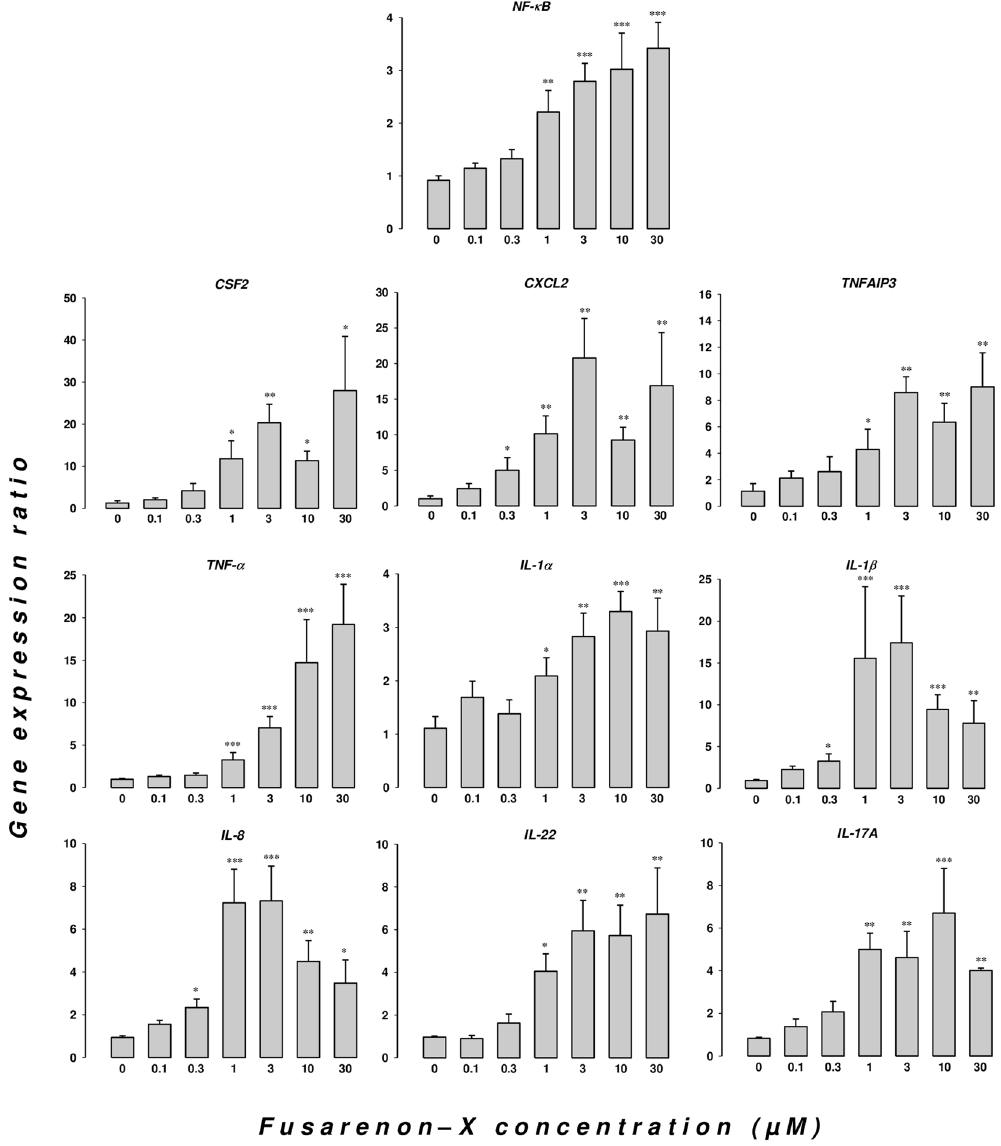
Figure 8. Dose-dependent regulation of inflammatory genes in the intestine upon exposure to FX. Dose- responses for the FX regulatory gene expression levels in the pig intestine. Jejunal explants from 6 piglets were exposed for 4 hours to graded levels of the trichothecene mycotoxin FX. The mRNA expression levels of NF- κ B , CSF2 , CXCL2 , TNFAIP3 , TNF- α , IL-1 α , IL-1 β , IL-8 , IL-17A and IL-22 were measured by quantitative RT-PCR and analyzed using the REST© 2009 software (Qiagen, Valencia, CA, USA). β 2-Microglobulin and RPL-32 were used as the internal references. The data are the mean ± SEM (n = 6 animals). The symbols * , ** , and *** indicate significant differences in gene expression ratios for the treated conditions compared to the control conditions (p < 0.05, p < 0.01, and p < 0.001,